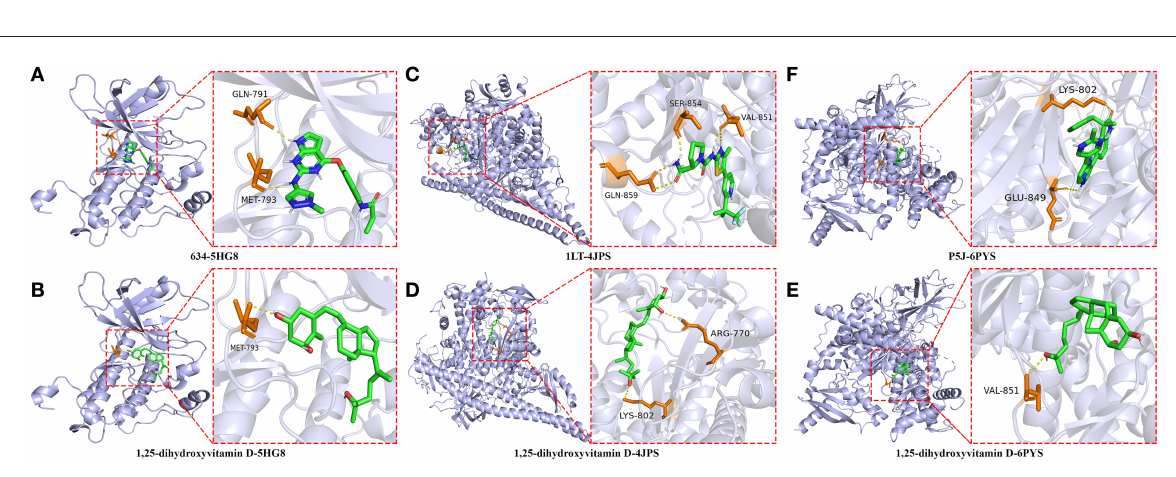
were identified by applying network pharmacology that is a frequently-used approach to pharmaceutical research for multiple diseases included COVID-19 and DM. Previous